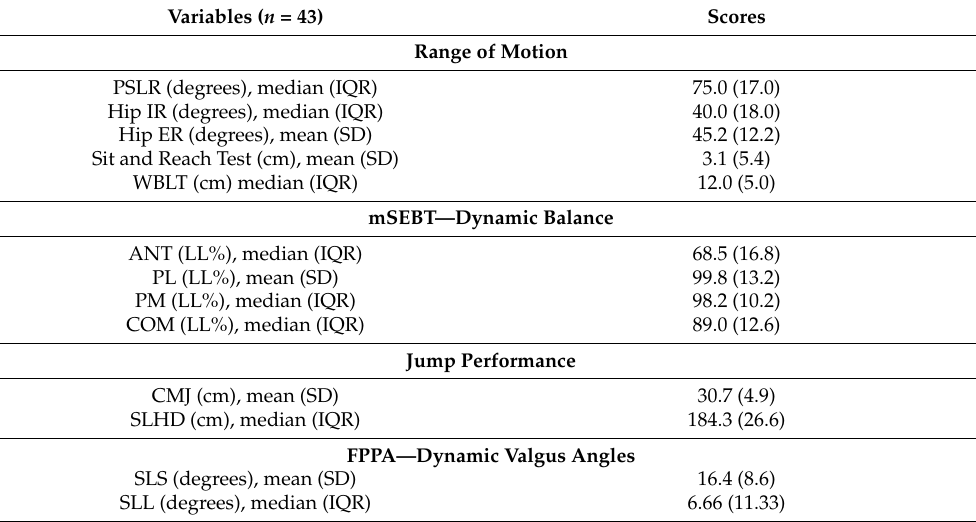
Table 2. Characteristics of the range of motion, jump performance, and dynamic knee valgus of the